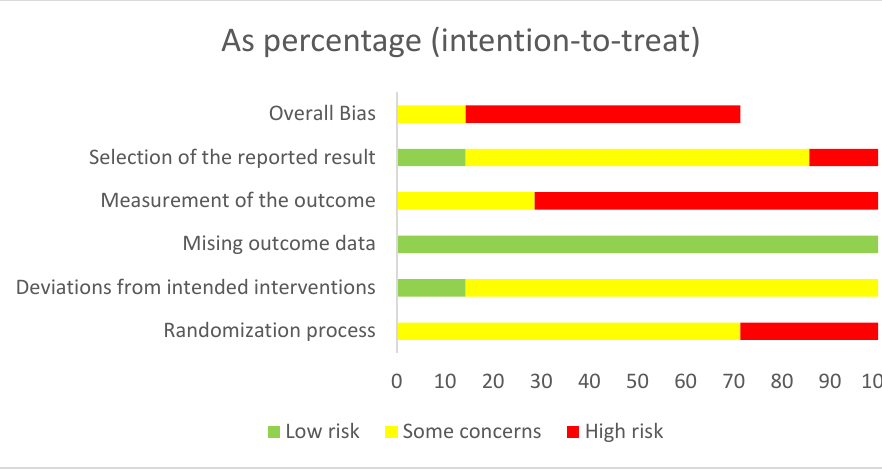
Figure 2. Quality assessment using RoB 2 Tool.